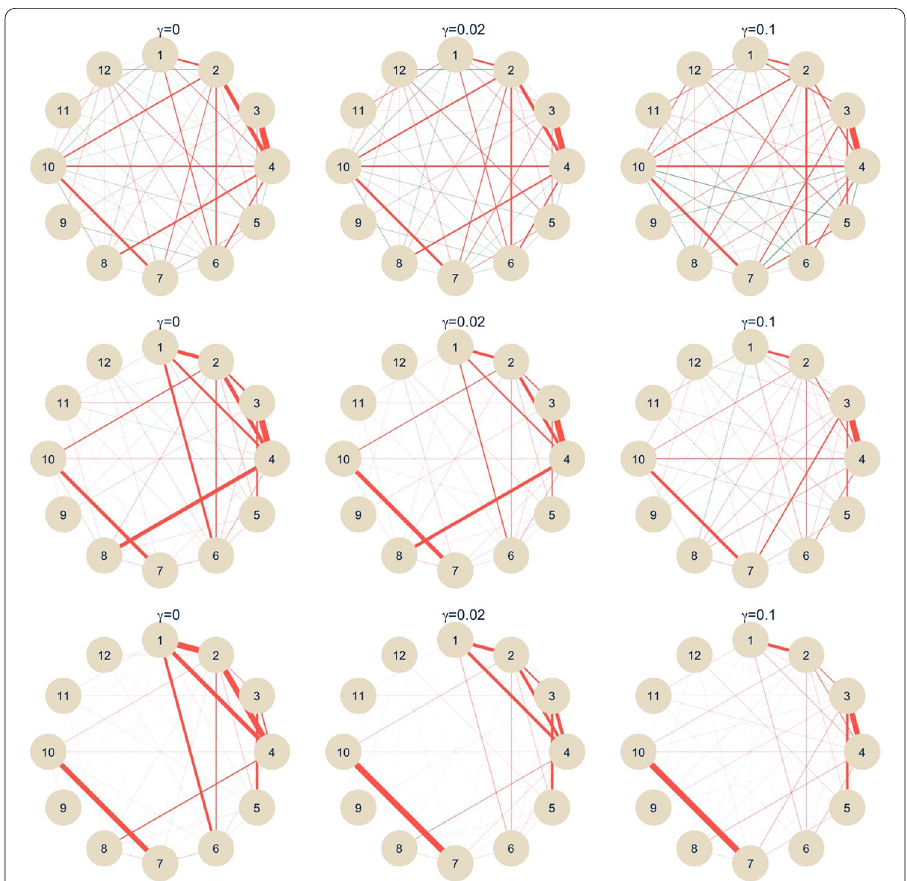
Fig. 8 Conditional correlations around May 15, 2020, using the bandwidth parameter h = 20 (first row), h = 50 (second row) and h = 100 (third row). The parameter γ refers to the robustness parameter: γ = 0 means no robust